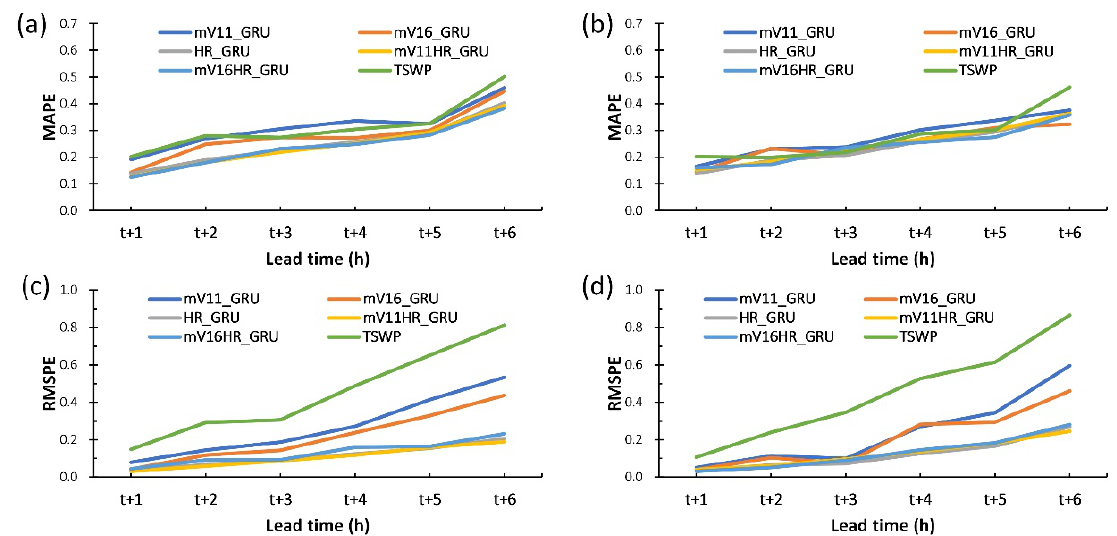
Figure 12. Metrics of ( a ) MAPE for the Longdong buoy, ( b ) MAPE for the Guishandao buoy, ( c ) RMSPE for the Longdong buoy, and ( d ) RMSPE for the Guishandao buoy. Table 7. Average of the MAPE and RMSPE and their IR at lead time of 1 to 6 h at Longdong and Guishandao buoys. Buoy Model